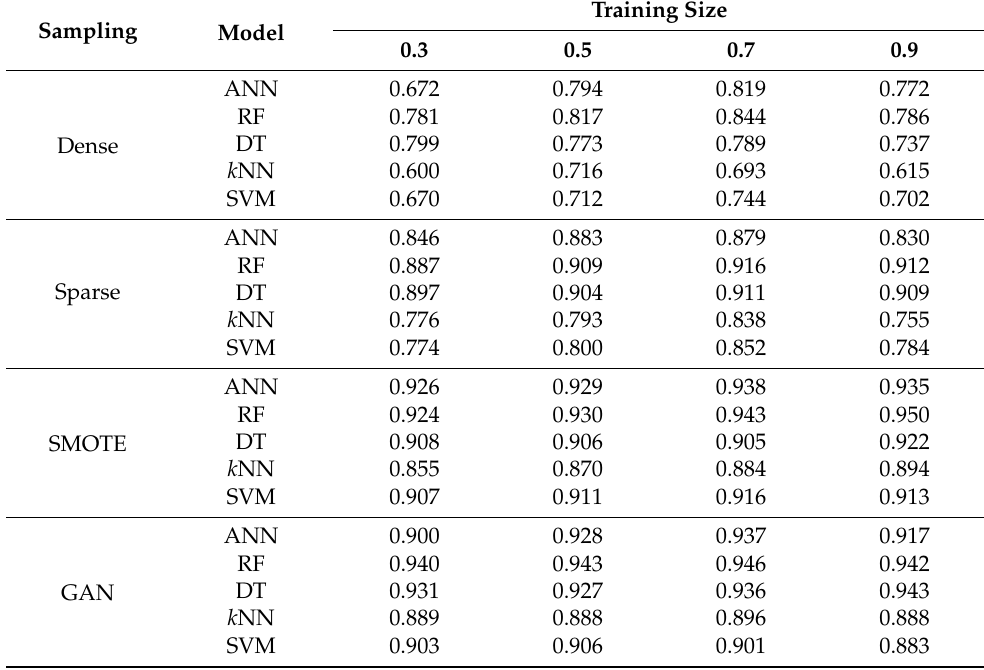
Table A7. Assessment of the models with different sampling methods based on F1-score.